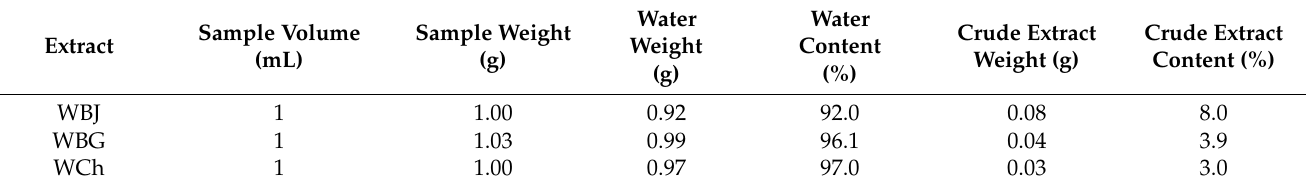
Table 1. Dry mass content [g/mL] in water